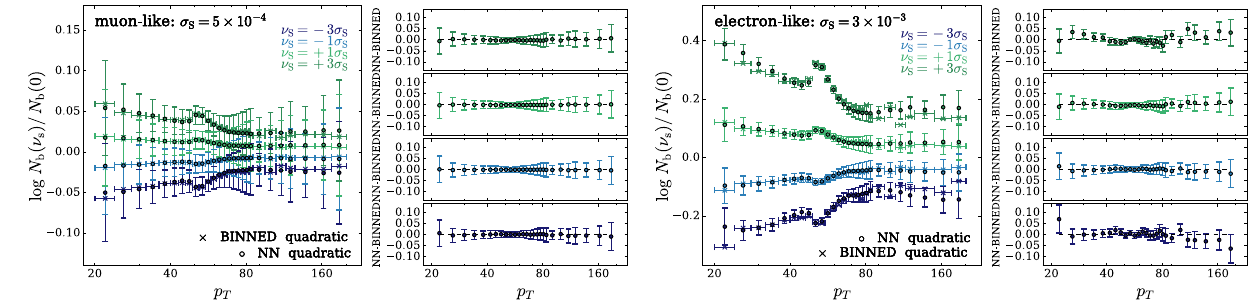
Fig. 14 The reconstructed distribution log-ratio (dots) for different values of ν s , compared with the quadratic binned approximation. The two panels cover the ranges of ν s that are relevant for the muon- and electron like scenarios respectively